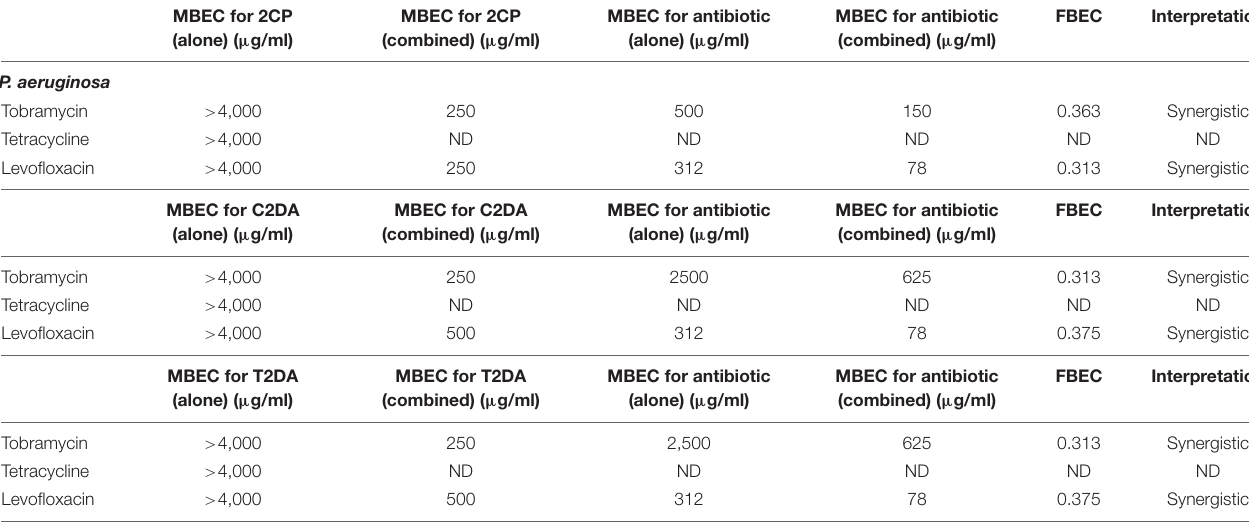
MBEC for 2CP (combined) ( µ g/ml)